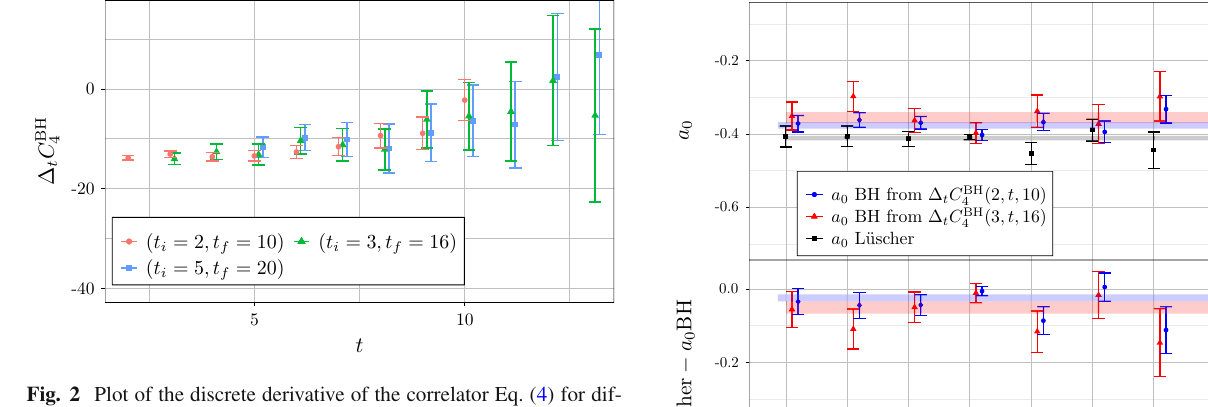
Fig. 2 Plot of the discrete derivative of the correlator Eq. (4) for dif- ferent values of t i and t f . We do not observe any systematic shift and all correlators are compatible. The points with smaller t i and t f tend to have smaller error